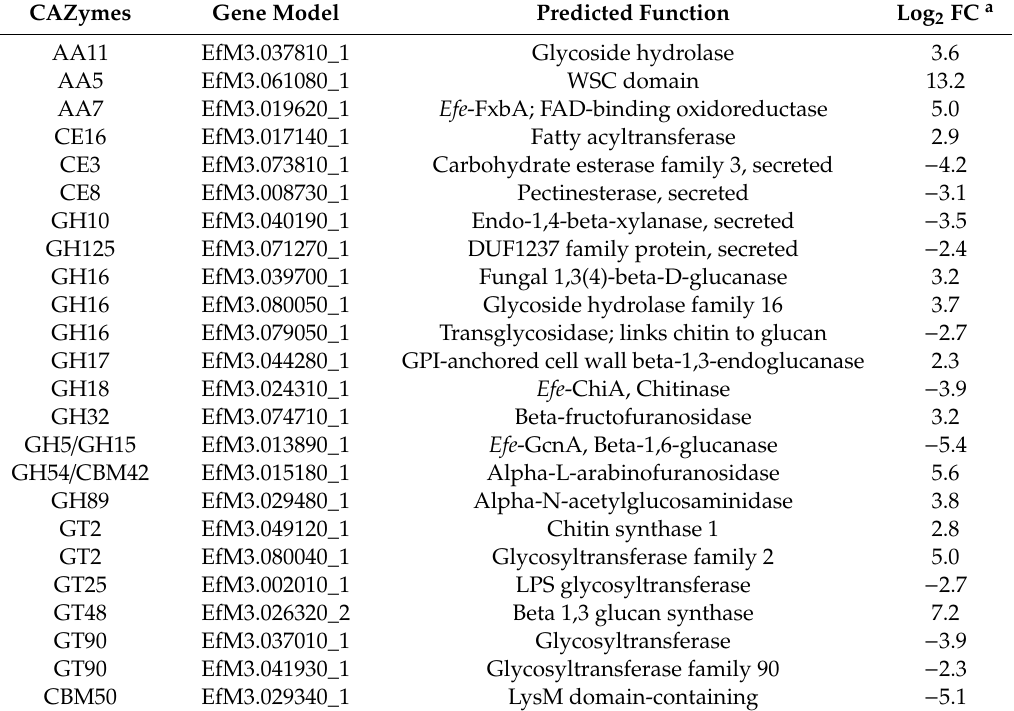
Table 6. Di ff erential gene expression in CAZyme genes at false discovery rate-adjusted p <